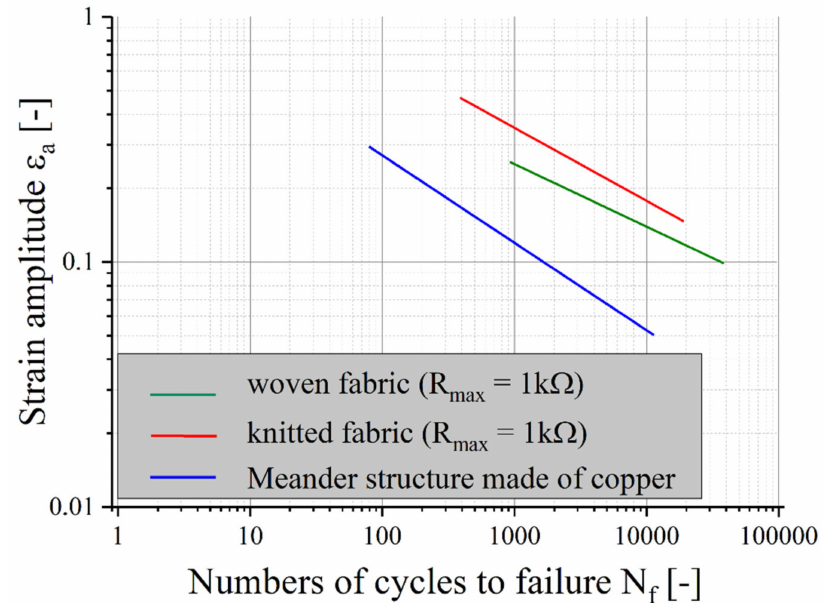
Figure 11. Life expectancy for elastic textile / polymer composites with conductors made of silver-plated woven or knitted textiles (R max = 1 k Ω ) compared with samples made of meandering copper tracks [26].